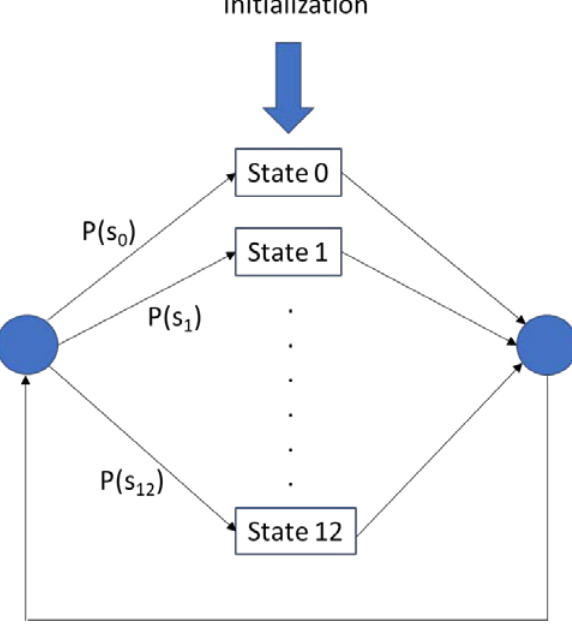
Figure 6 | Structure of the used HMMs.